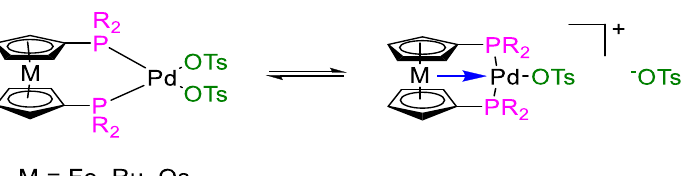
Figure 4. Non-trivial coordination of ferrocenylphosphine ligands with palladium: the dative iron – palladium bond.